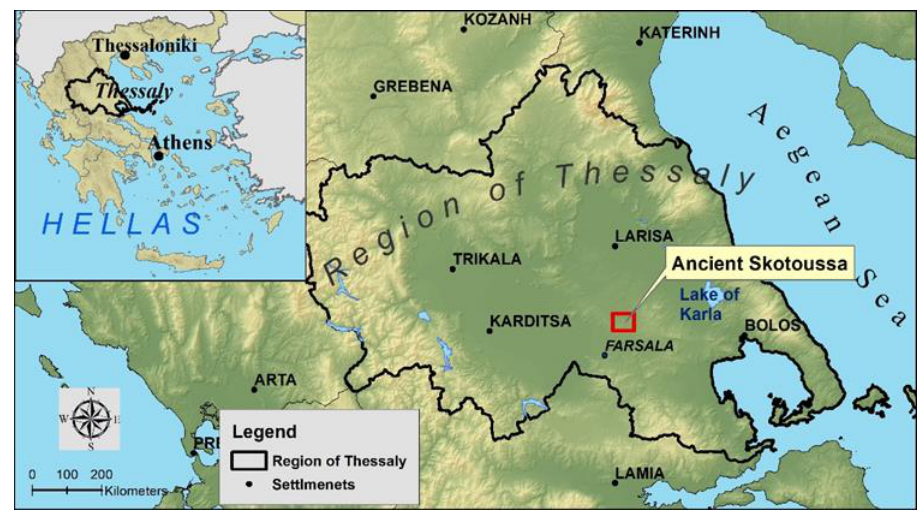
Figure 2. Study area, ancient Skotoussa.